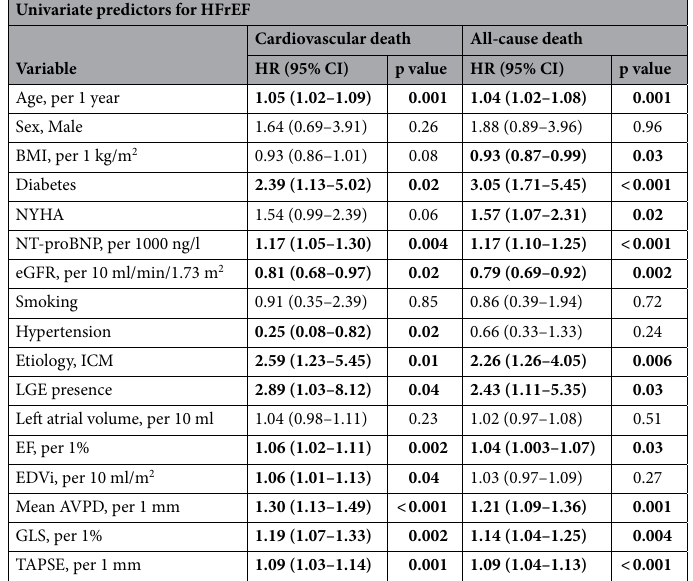
Table 2. Univariate predictors for the 5-year follow-up. Bold text indicates statistical significance. HR hazard ratio, CI confidence interval, BMI body mass index, NYHA New York Heart Association, BNP brain natriuretic peptide, eGFR estimated glomerular filtration rate, ICM ischemic cardiomyopathy, LGE late gadolinium enhancement, EF ejection fraction, EDVi end-diastolic volume indexed to body surface area, AVPD atrioventricular plane displacement, GLS global longitudinal strain, TAPSE tricuspid annular plane systolic